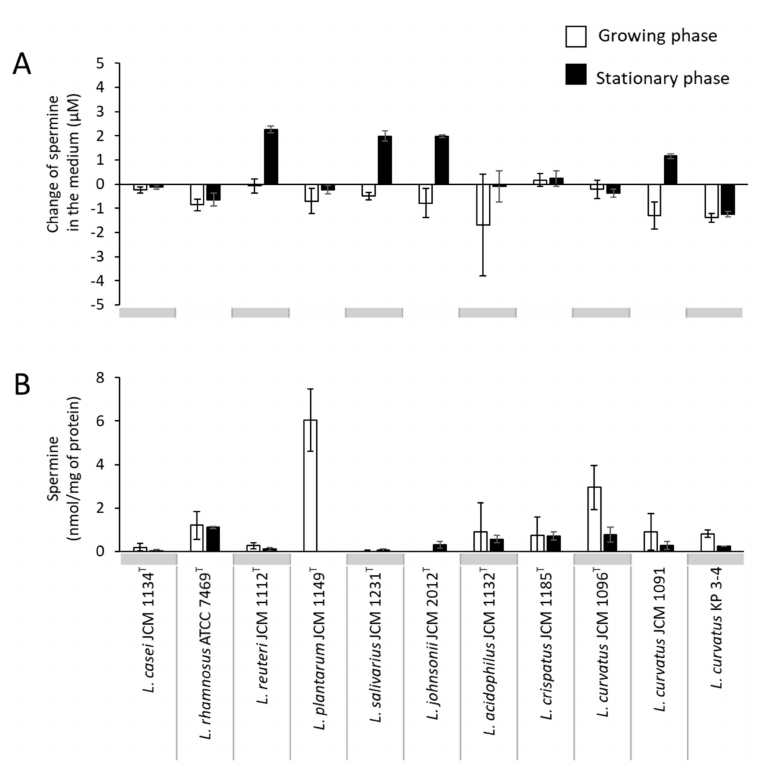
Figure 4. Spermine concentration in culture supernatant and in the cell of lactic acid bacterial strains. Lactic acid bacterial strains were cultured in the MRS medium anaerobically for a maximum of 82 h at 37 ◦ C. Spermine concentration in the culture supernatant ( A ) and intracellular spermine concentration ( B ) of the tested lactic acid bacterial strains in the growing phase and stationary phase. For ( A ), the values are shown as changes in the amount of polyamine from the MRS medium to the culture supernatant. White bars, growing phase; black bars, stationary phase. Data represent means ± standard deviation from biological replicates ( n =